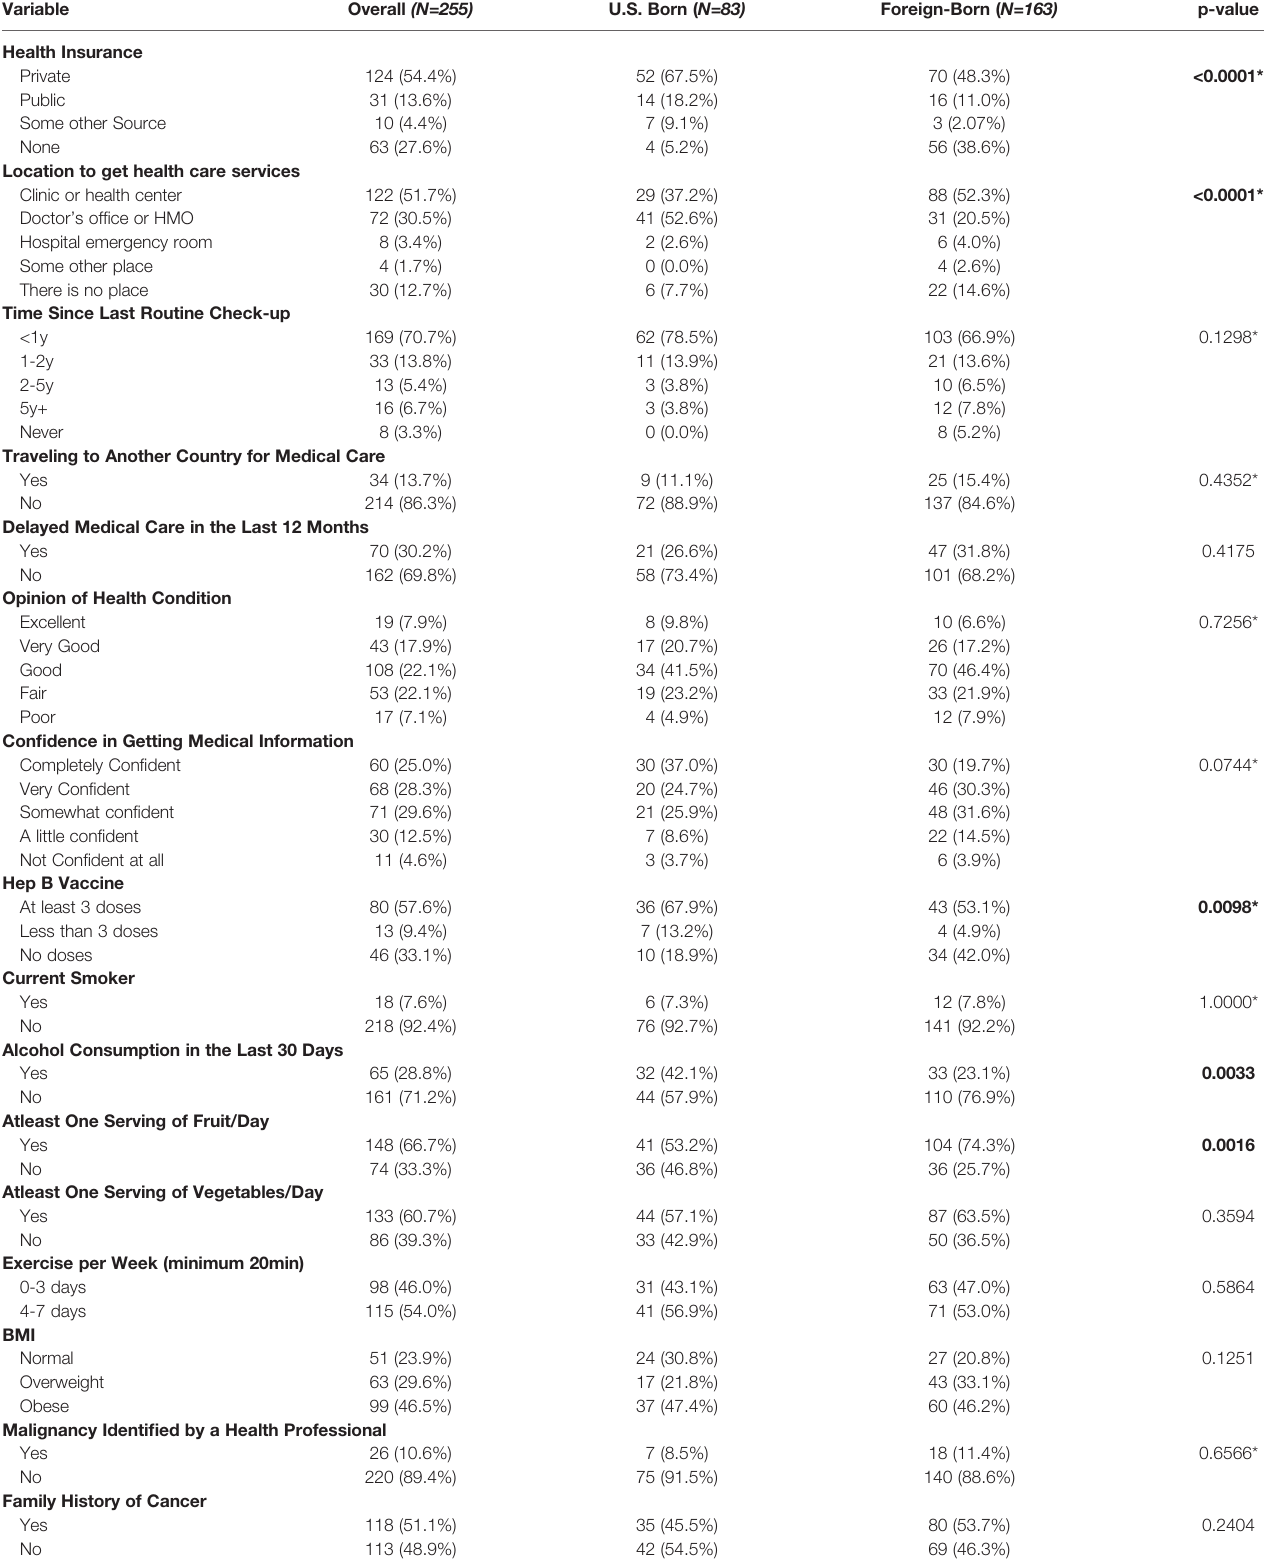
TABLE 2 | Health characteristics of participants strati fi ed by nativity. ( N = 246)